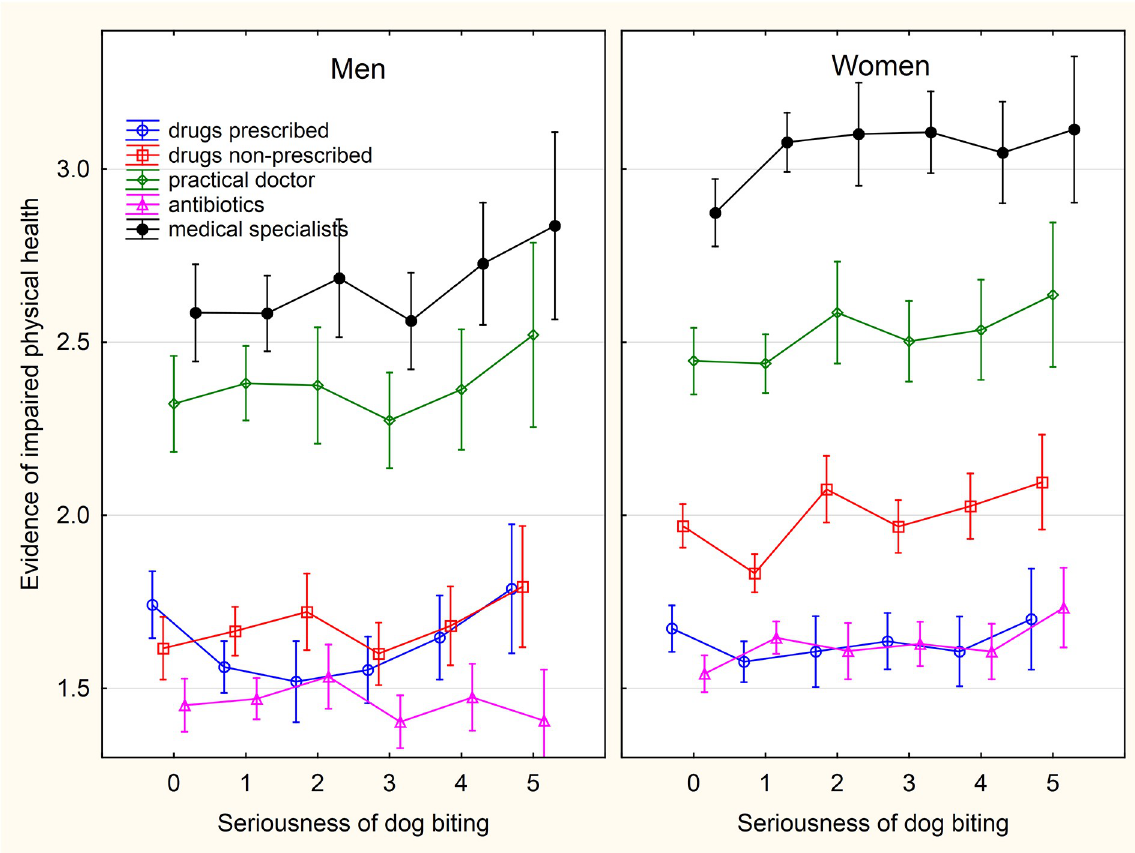
Fig 5. Association between intensity of sustained dog biting and physical health related variables. The categories on x-axis describing the intensity of being injured by a pet are: 0- never, 1- only while playing, 2- only as a warning, 3- yes, minor injury (only skin cut), 4- yes, moderate injury (bleeding), 5- yes, serious injury, I had to seek medical